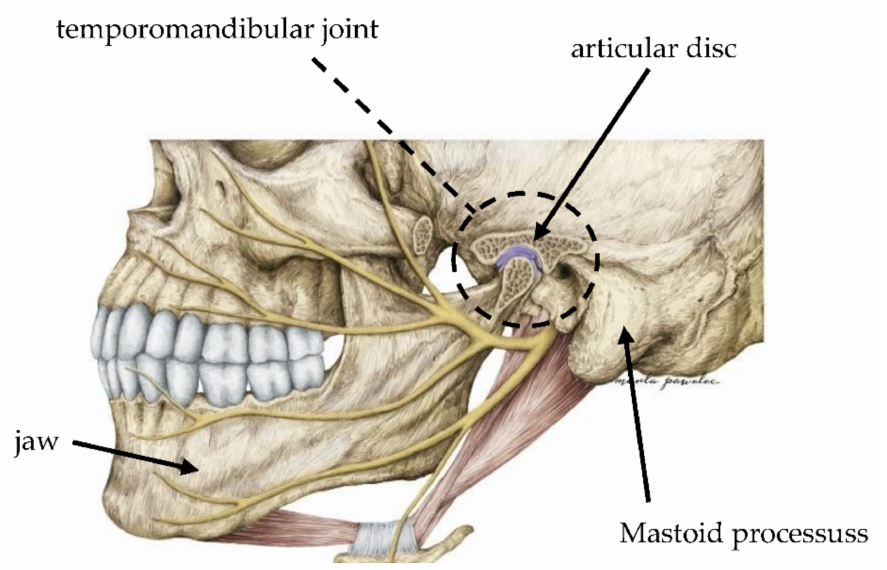
Figure 1. Anatomy of the area of temporomandibular joint